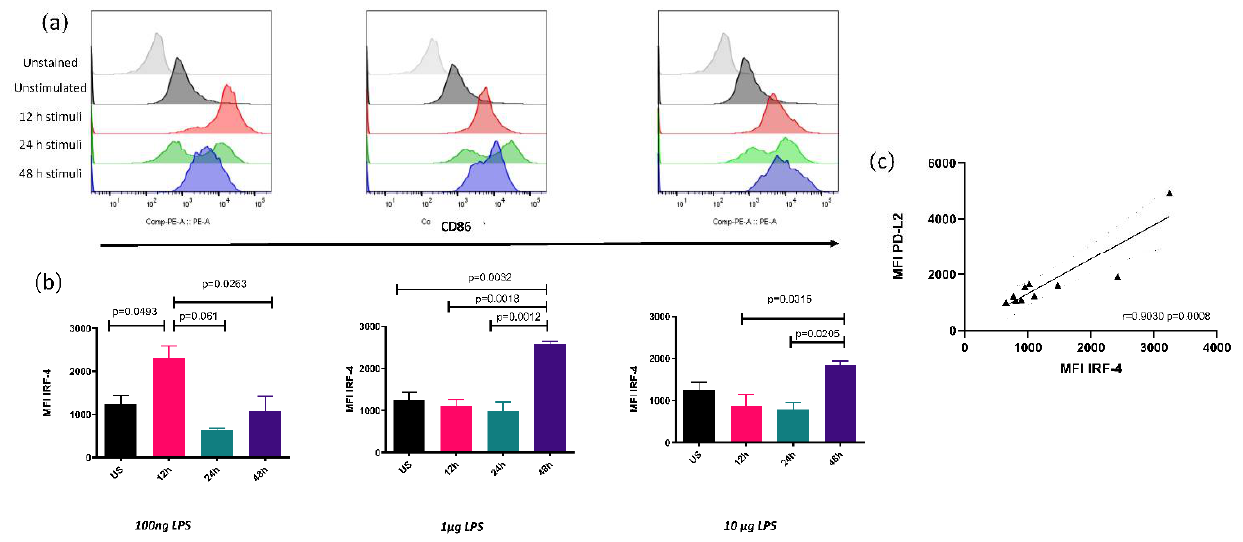
Figure 3. IRF4 shows a differential kinetic expression and correlates with PDL2 expression. ( a ) Representative histogram for IRF4 in different experimental conditions. ( b ) Mean of MFI ± SD for 3 independent assays performed in triplicate is depicted. ( c ) Pearson’s correlation between IRF4 and PDL2 expression. ▲ Represents individual correlation plots.